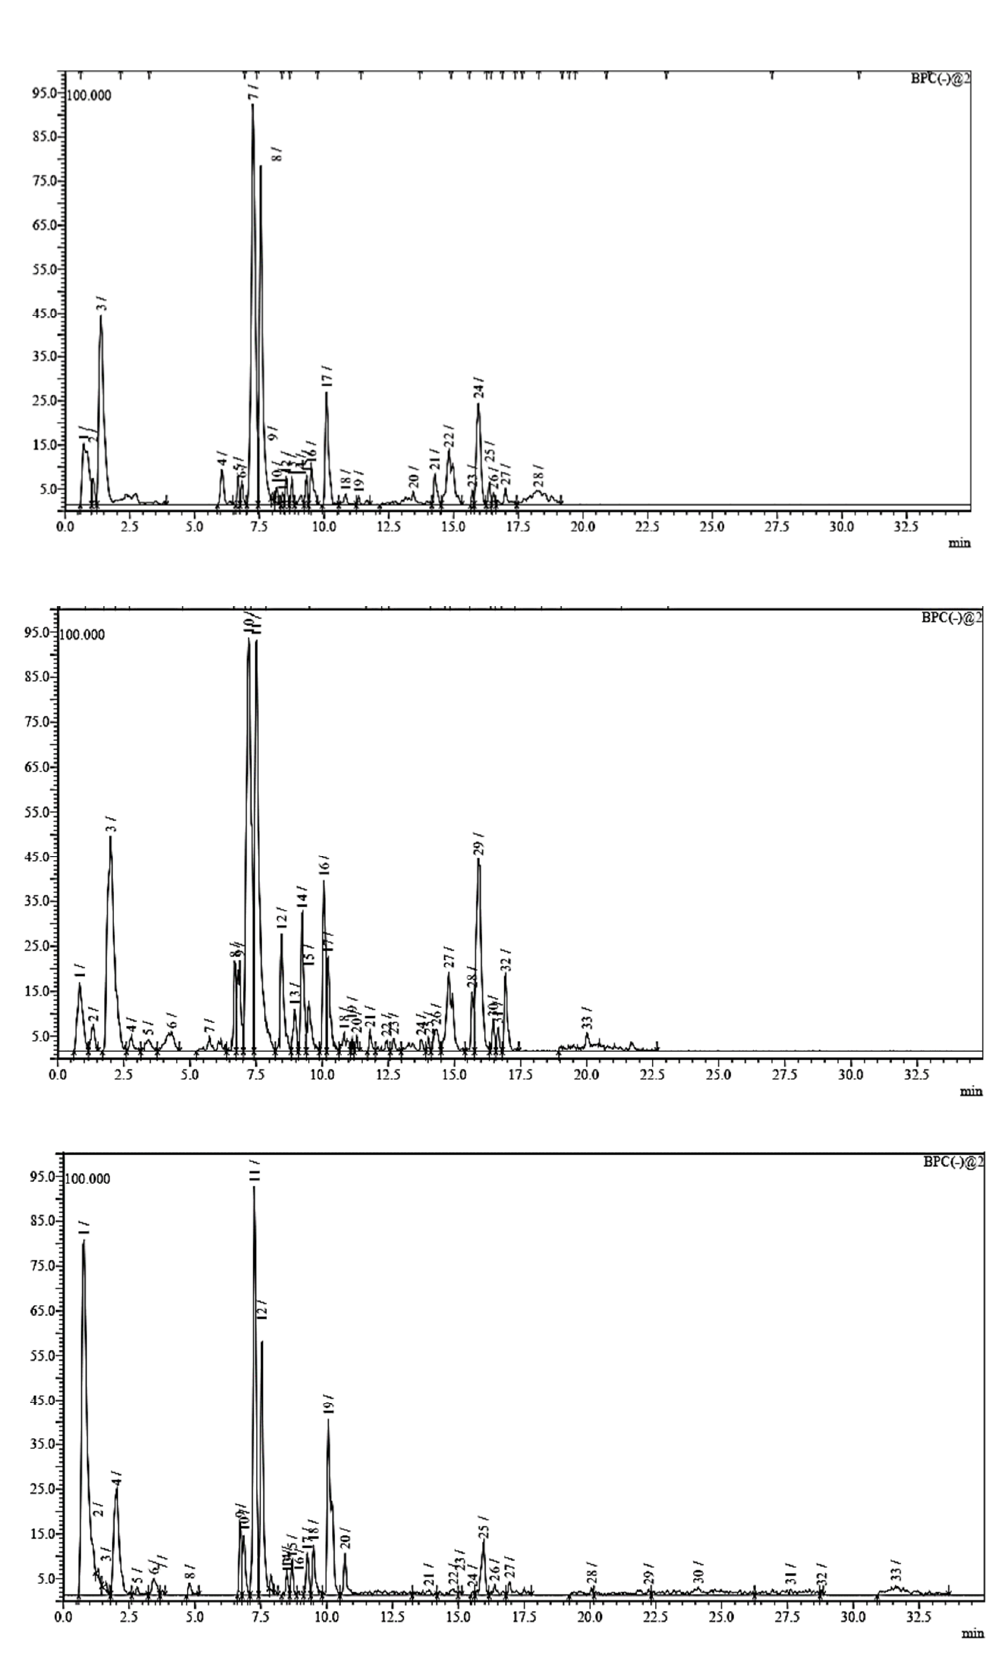
Figure 7. UPLC-ESI-MS chromatograms of crude extracts of bract ( A ), flower ( B ), and stem ( C ) of C. scolymus